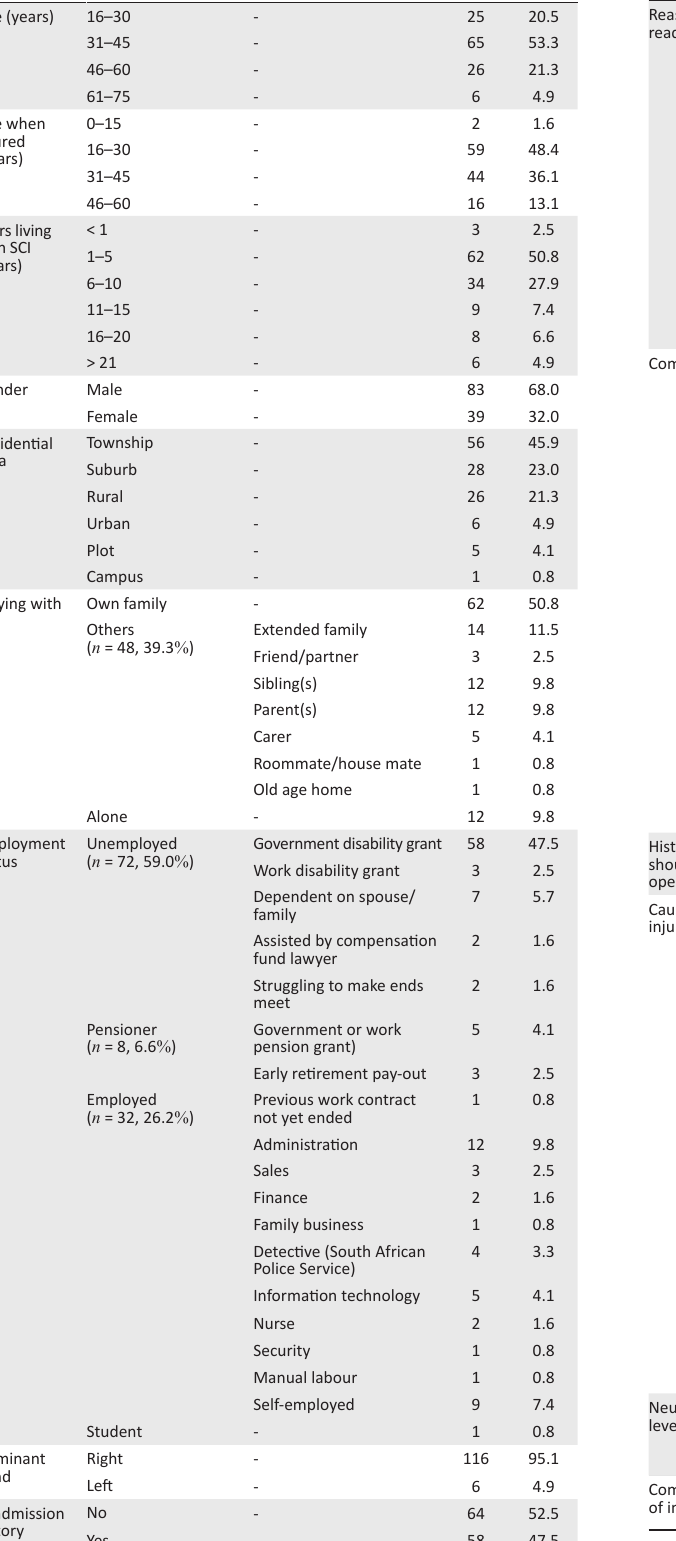
TABLE 1: Participants’ sociodemographic and injury profile ( n = 122). Description